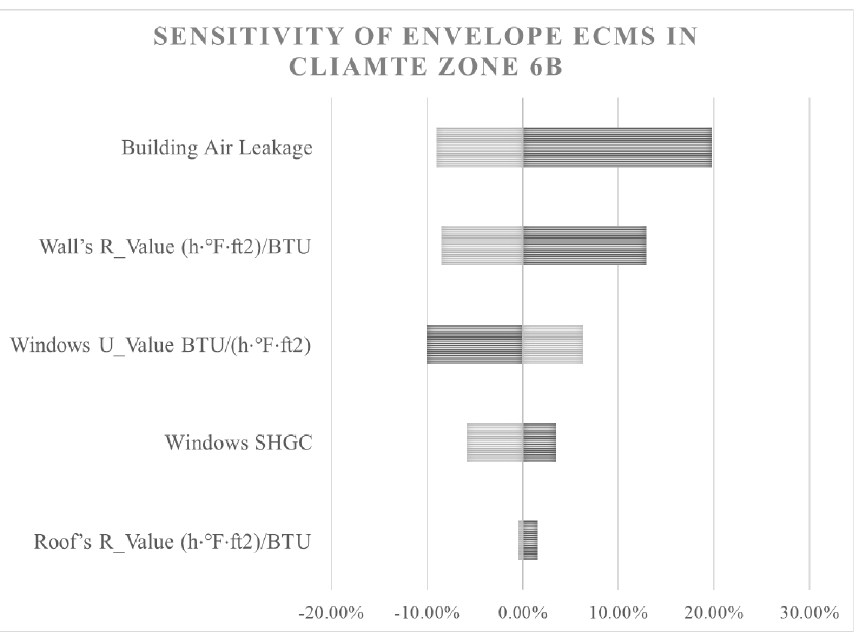
Figure 17. Sensitivity analysis based on energy-saving potentials for different envelope ECMs in climate zone 6B (i.e., cold and dry). climate zone 6B (i.e., cold and